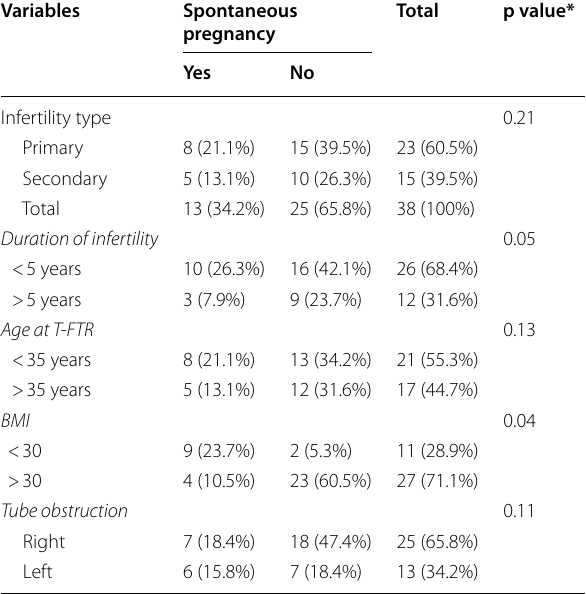
Table 1 Transcervical fallopian tube recanalization (T‑FTR) conception